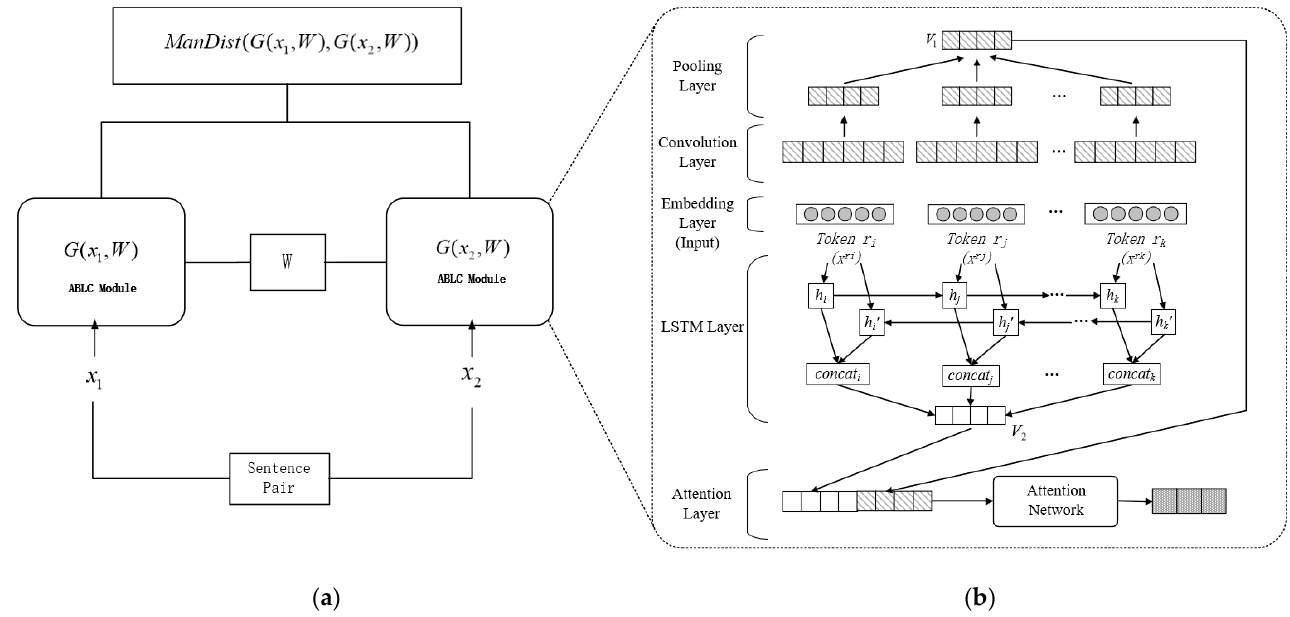
Figure 2. ( a ) Overall framework of the contrast learning model. ( b ) The structure of ABLC model.